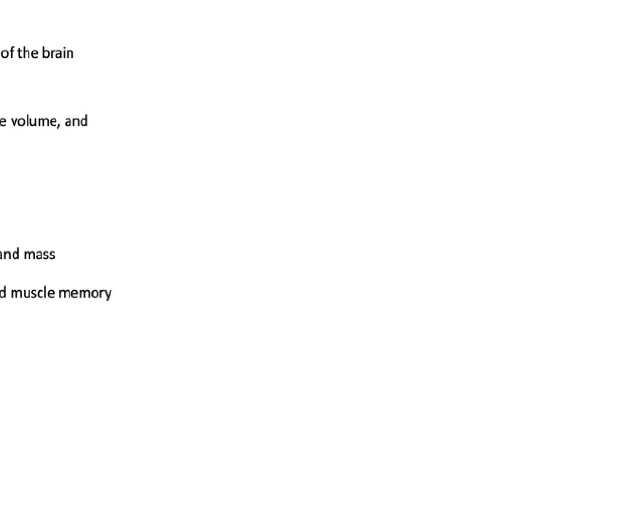
Figure 1. Irreversible changes to male physiology. Figure 1 shows the irreversible changes of testosterone conditioning throughout life. Testosterone masculinizes the brain in utero and during early life. Testosterone drives anatomical structure design specific to the male skeleton. Testosterone drives muscle mass, muscle fiber type, and muscle memory. Most of the effects driven by testosterone cannot be reversed with estradiol (or cross) hormone therapy.